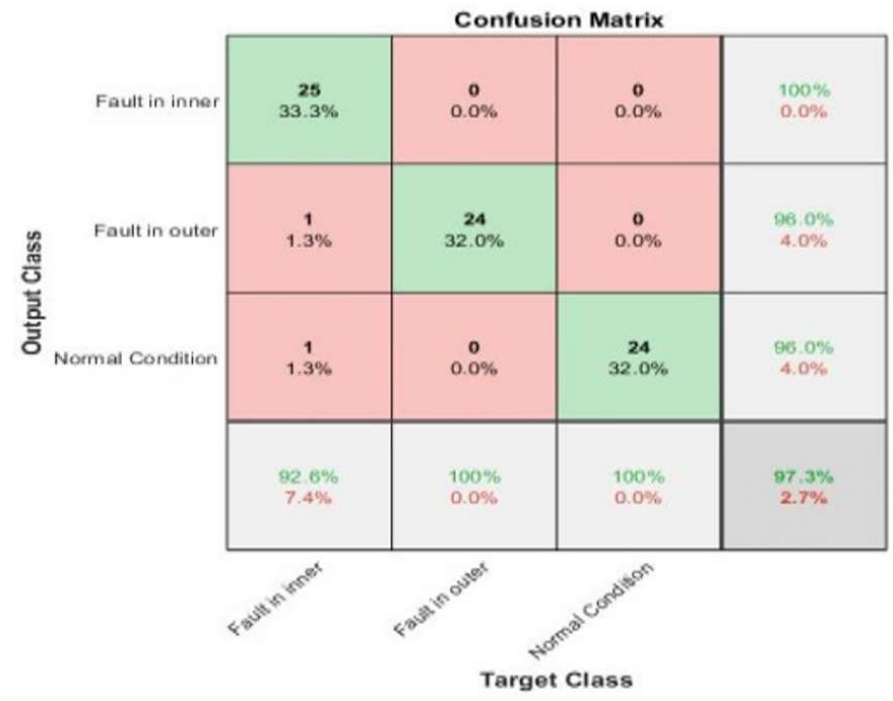
Figure 7. Confusion matrix on the MFPT dataset.